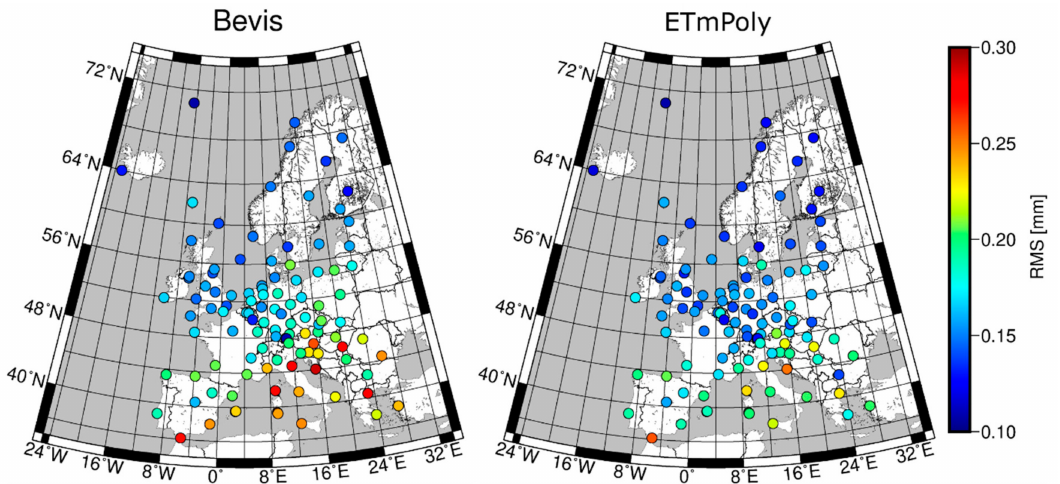
Figure 6. RMS values of the precipitable water vapor (PWV) estimated using Bevis (left) and ETmPoly (right) coe ffi cients. The PWV derived from RS profiles were adopted as a reference.